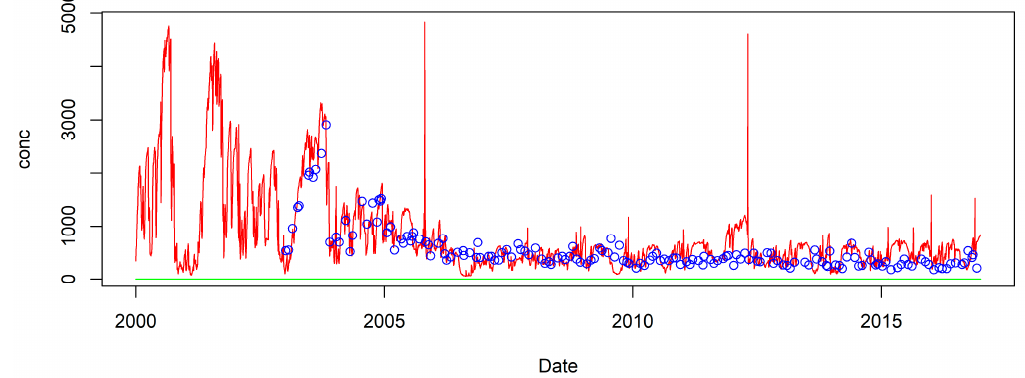
Figure 7. Time series plot of baseline concentration of TP (ug/L) from 2000 to 2016 with observations in blue highlighting changing because of point source improvements (sewage treatment work upgrade). Diffuse improvement was at most 3.96 ug/L.